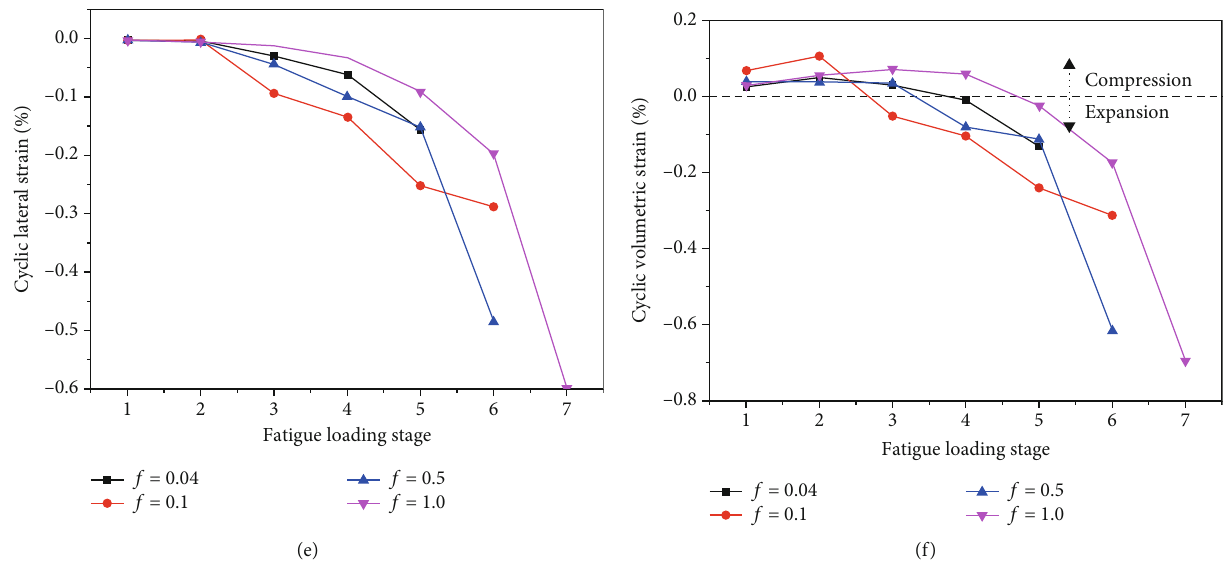
Figure 4: The relationship between the maximum strain and dynamic cyclic number. (a – c) Plots of the maximum axial strain (a), maximum lateral strain (b), and maximum volumetric strain (c) against cyclic number at a fatigue loading stage. (e, f) Plots of the cyclic axial, lateral, and volumetric strain against fatigue loading